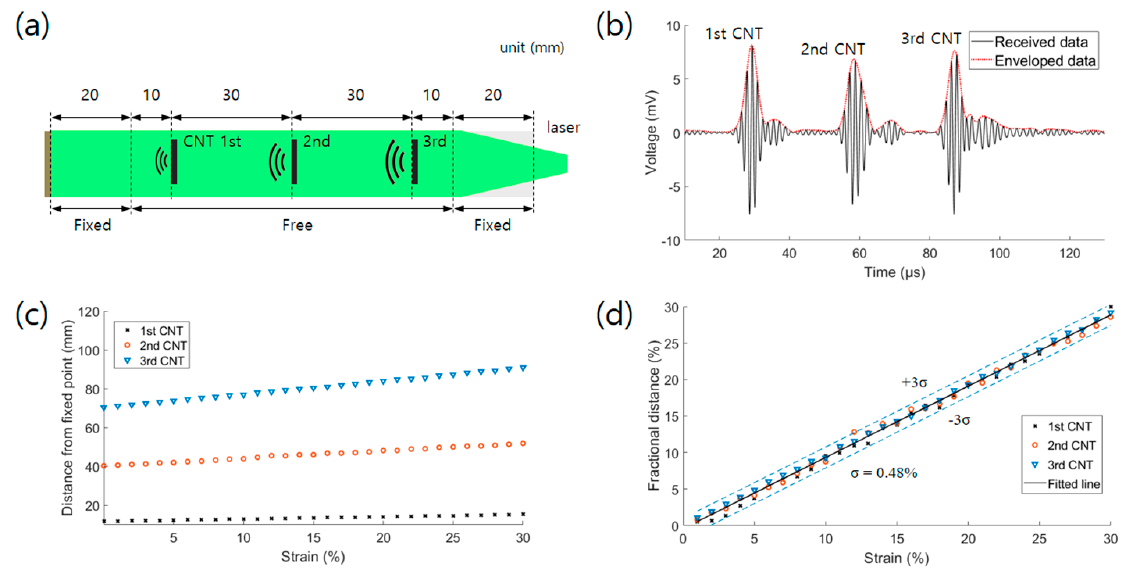
Figure 7. ( a ) Sensor structure used in the multipoint expansion experiment; ( b ) Received and enveloped data before the stretching; ( c ) Data of the transmission time from the initial point of the free range of the sensor according to the strain up to 30% (intervals of 1%); ( d ) Converted data from ( c ) to fractional time changes.